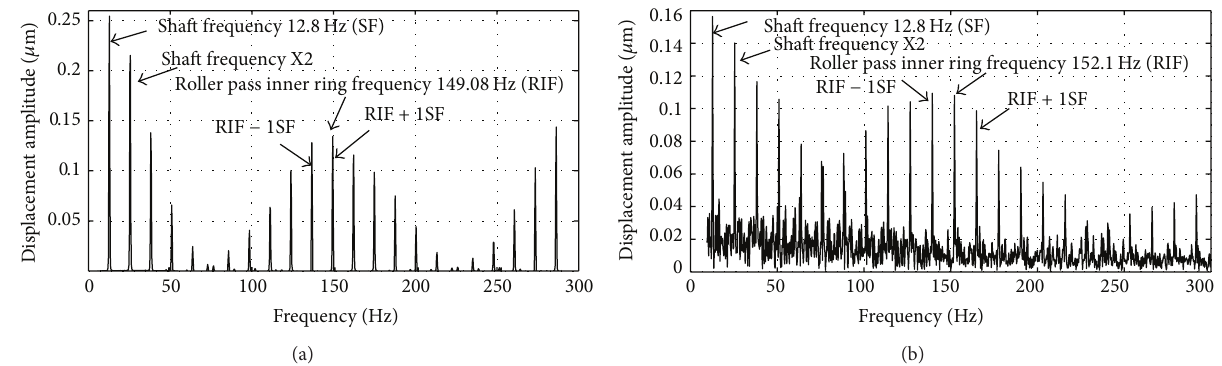
Figure 19: Vertical displacement amplitude for inner ring defect: (a) simulation; (b) measurement data.